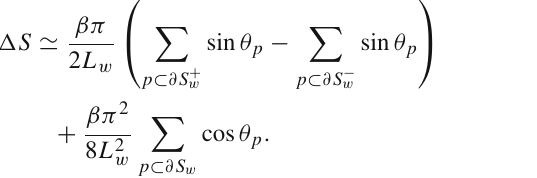
Fig. 4 correspond to the two-parameter